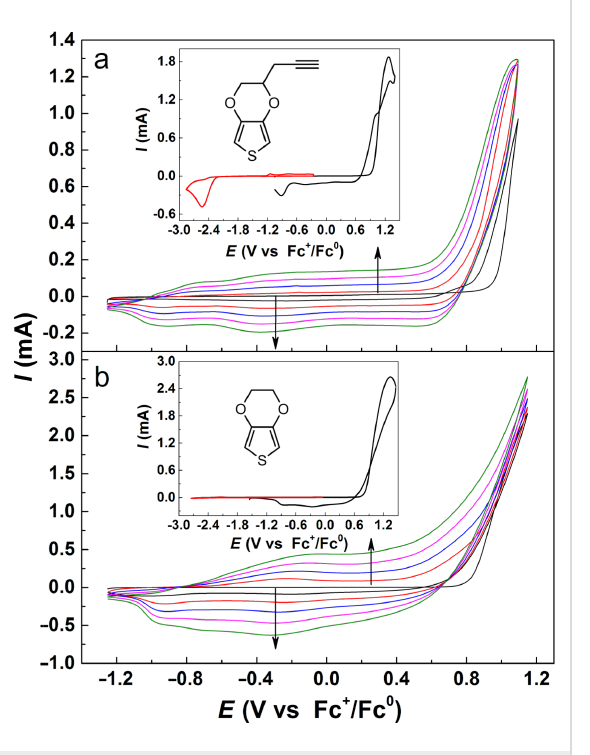
Figure 1: CVs of electrochemical polymerization of (a) pyEDOT 3 and (b) EDOT in MeCN solution with 0.1 M TEAPF 6 , glassy carbon elec- trode, 0.1 V s − 1 . Insets show the structure and voltammograms for the monomers.